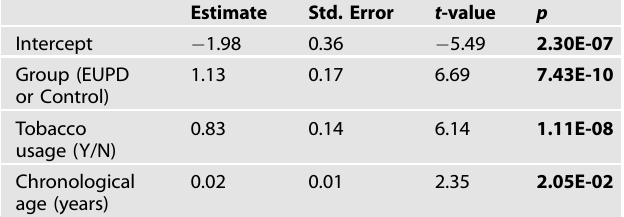
Fig. 3 Grim epigenetic age acceleration and DNA methylation-based telomere length. A , B Scatterplots show GrimAge or DNAmTL vs. chronological age. Pearson ’ s correlation analysis indicated a signi fi cant correlation between GrimAge/DNAmTL and chronological age in both groups. C , D Violin plot with boxplots shows Grim EAA or DNAmTLAdjAge. Student ’ s t -test demonstrated signi fi cantly higher GrimAgeAccel in EUPD subjects ( p = < 0.00001). EAA epigenetic age acceleration, DNAmTL DNA methylation-based telomere length, DNAmTL AdjAge age- adjusted DNAmTL. Table 2. Multiple linear regression model contrasting Grim Age Acceleration to group (EUPD or control) and optimal